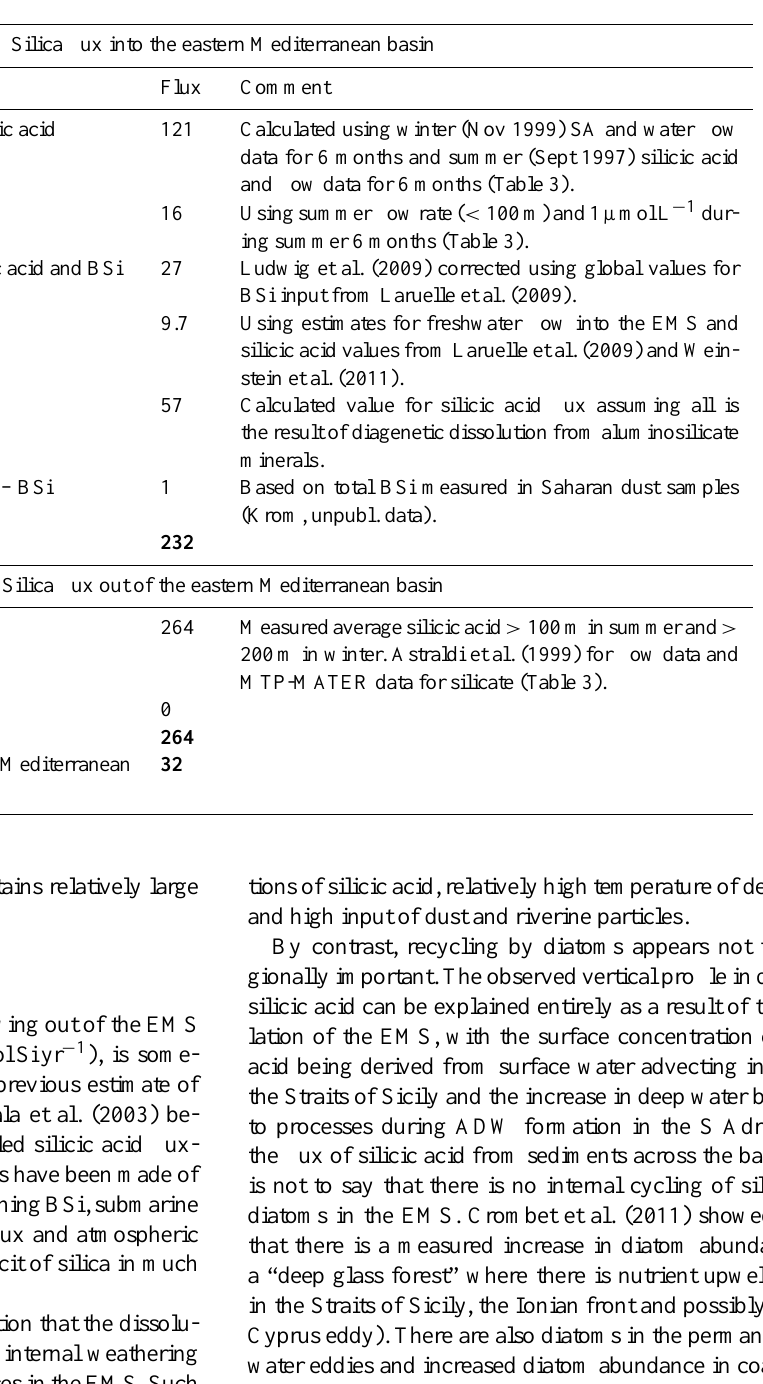
Table 4. Total silica budget for the eastern Mediterranean Sea. The fluxes are in units of 10 9 molSiyr − 1